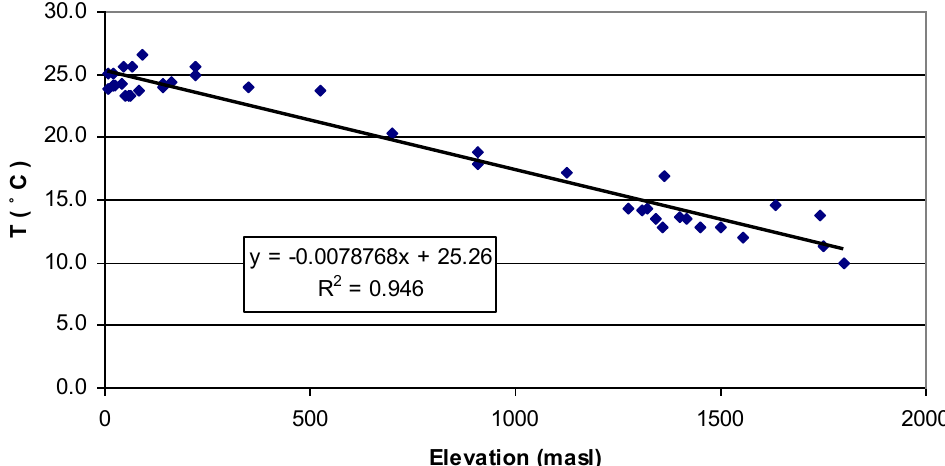
Figure 4. Temperature and altitude Relationship in Ilam